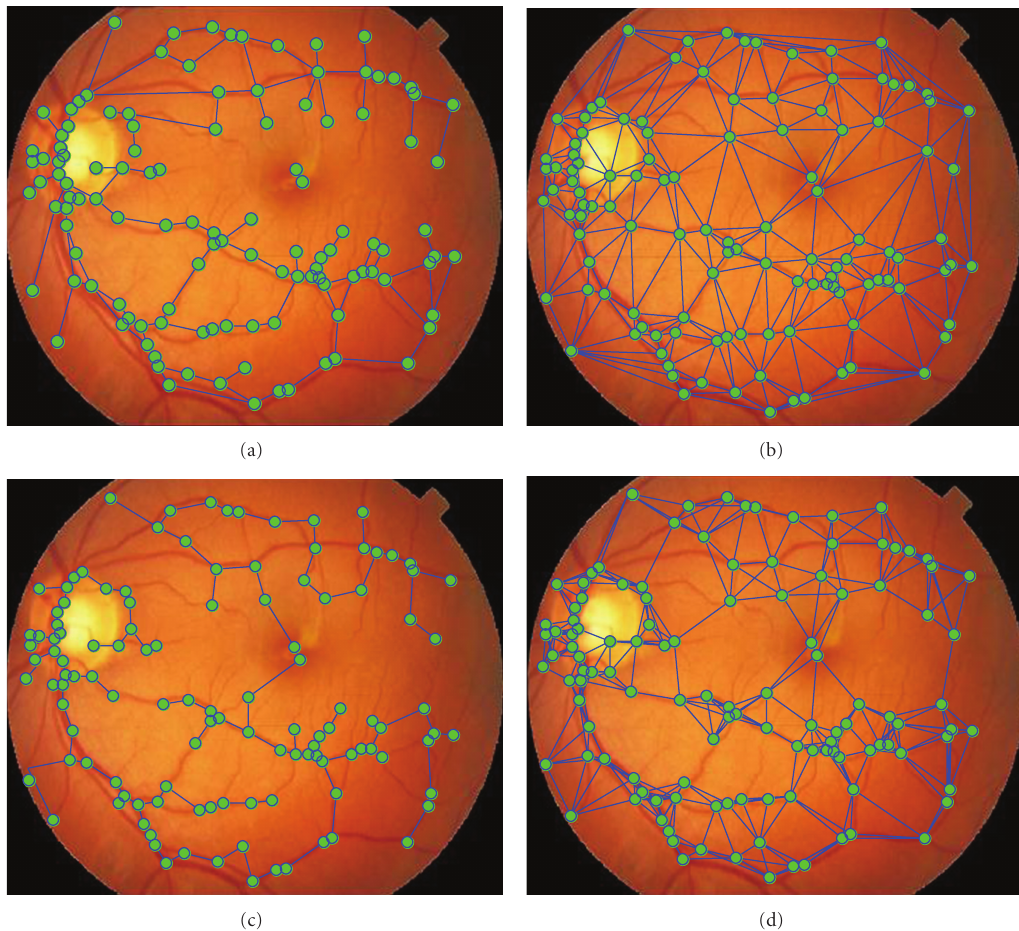
Figure 8: Illustrations for various topological graph structures investigated in our experiment. (a) Vascular structure graph, (b) Delaunay triangulation graph, (c) Minimum spanning tree of DT graph, (d) k-Nearest neighbor